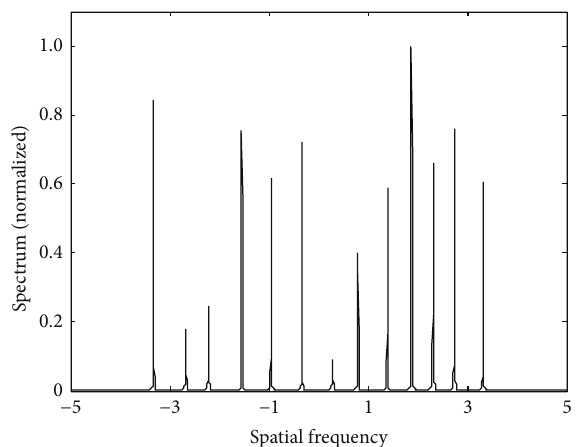
Figure 2: Spatial frequency estimated results of 13 source signals, 𝑁 = 6 , 𝑀 = 32 , 𝐿 = 1024 , and SNR = 15dB.